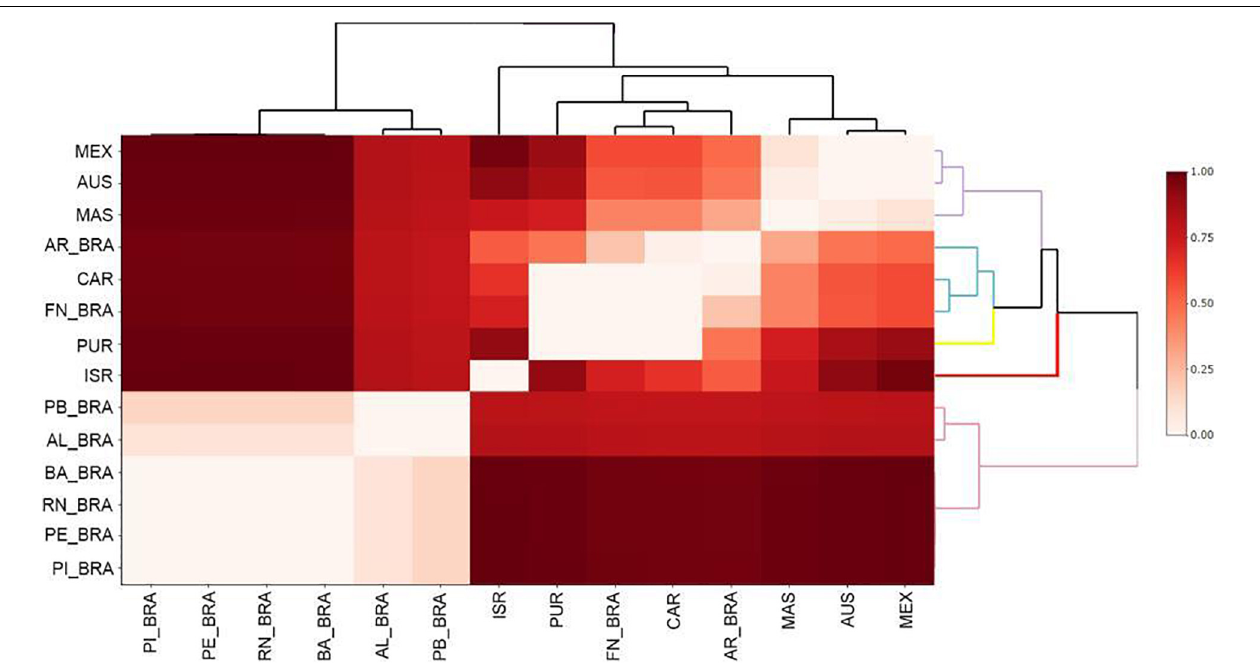
FIGURE 3 | Heatmap of the 14 sampling areas of Eretmochelys imbricata with cluster analysis with Euclidean distance and cluster average method based on F ST values. The lines with different colors in the cluster, indicate the five groups identified. Piauí—PI_BRA; Alagoas—AL_BRA; Bahia—BA_BRA; Rio Grande do